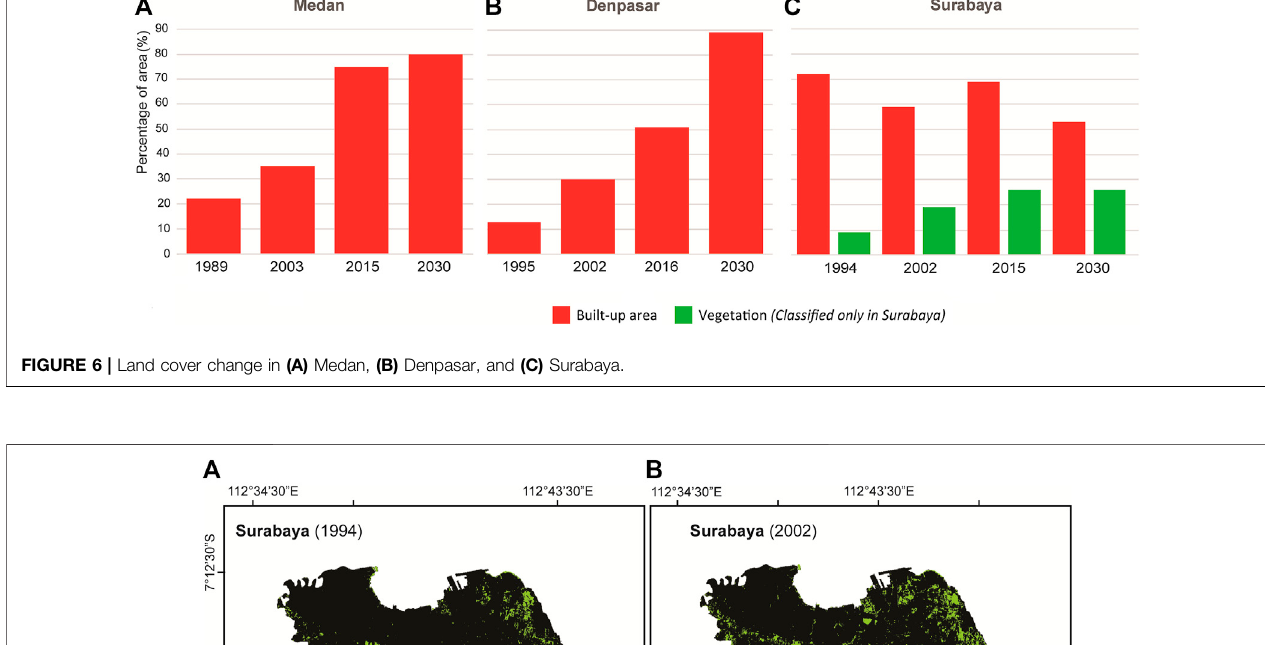
Frontiers in Built Environment |